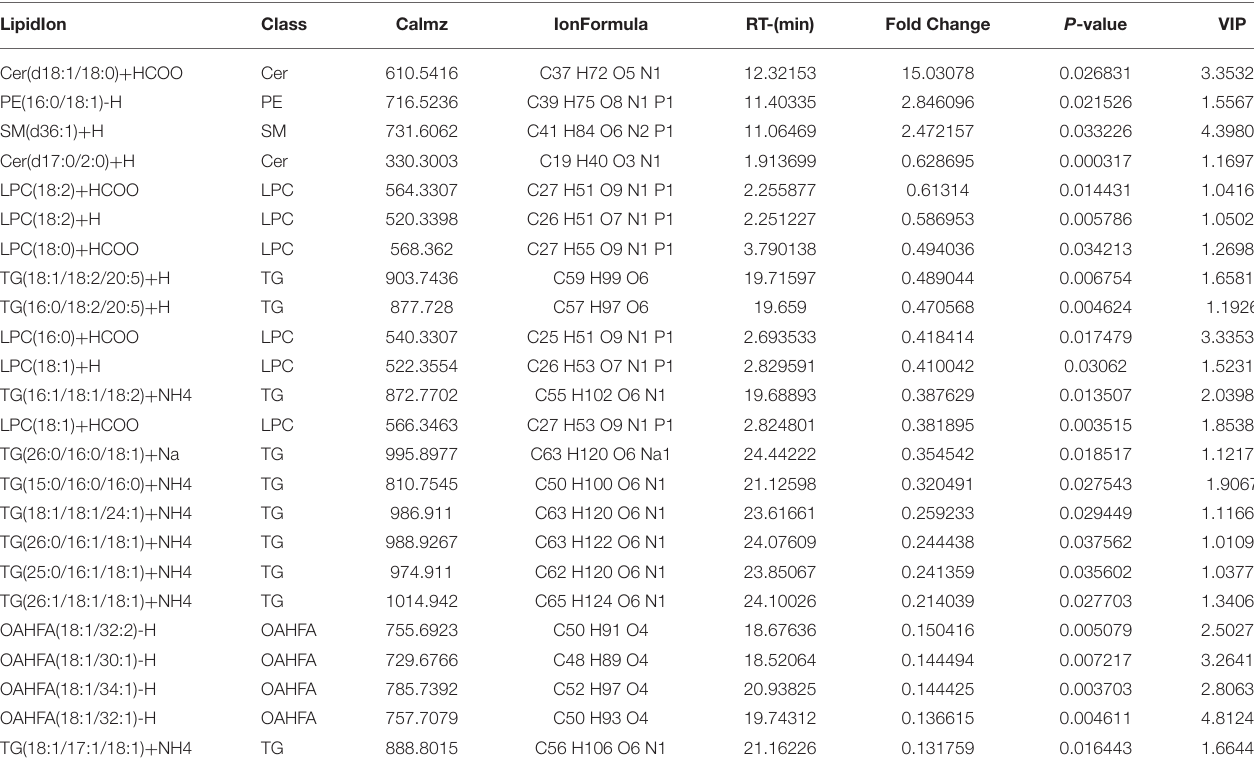
TABLE 3 | Significant different subclasses of lipids of T2 ( n = 26) verse T0 ( n = 26). LipidIon Class